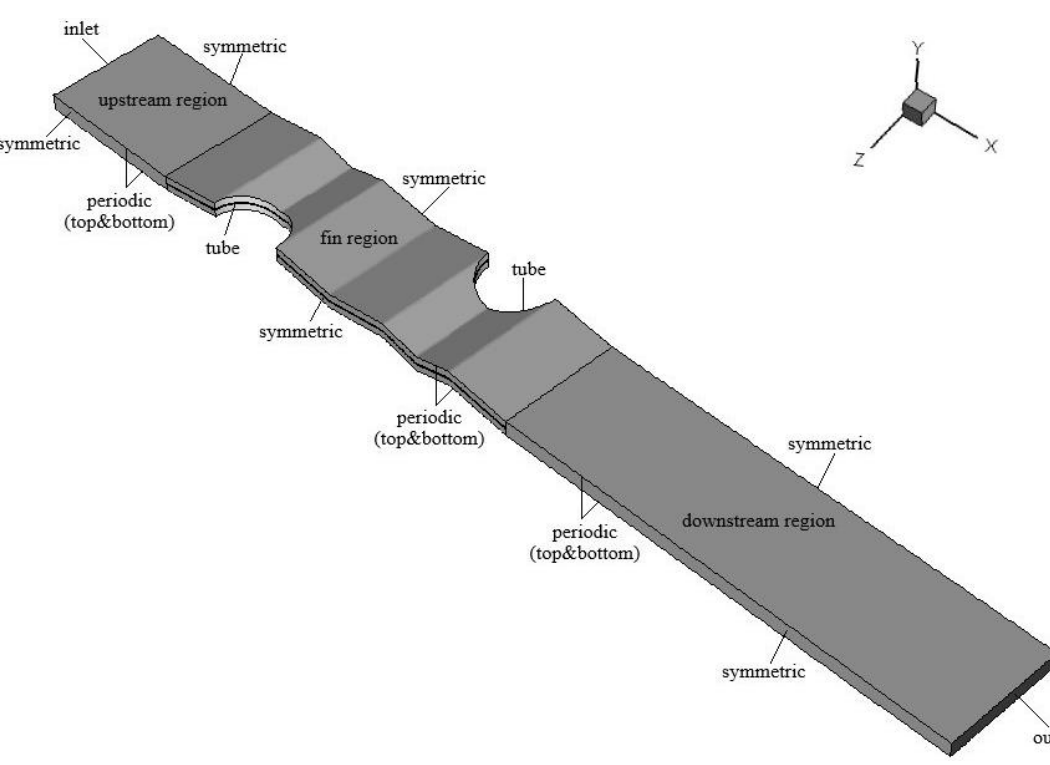
Figure 2. Computational domain of simulated wavy fin. Table 1. Geometrical parameters of simulated wavy fins.